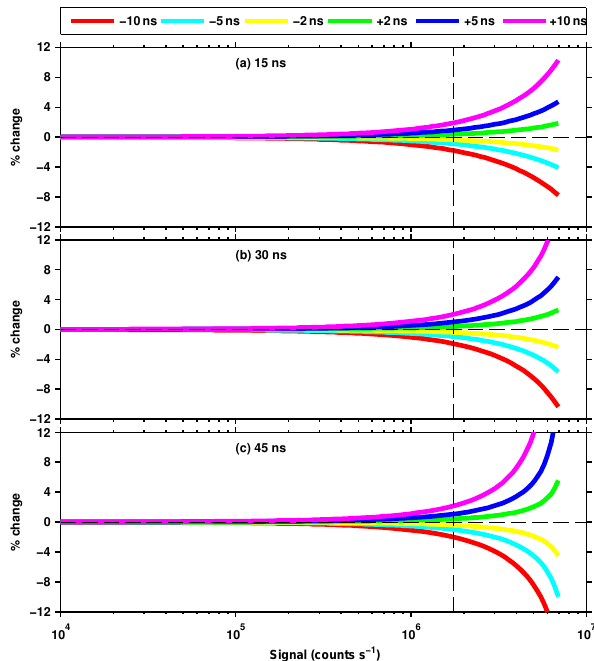
Figure 5. Changes in UV irradiance as a function of the measured signal due to errors in the determination of DT, for different values of the reference DT: (a) 15ns, (b) 30ns and (c) 45ns. The vertical dashed line marks the cut-off limit of ∼ 1 . 75 × 10 6 countss − 1 used for direct-Sun